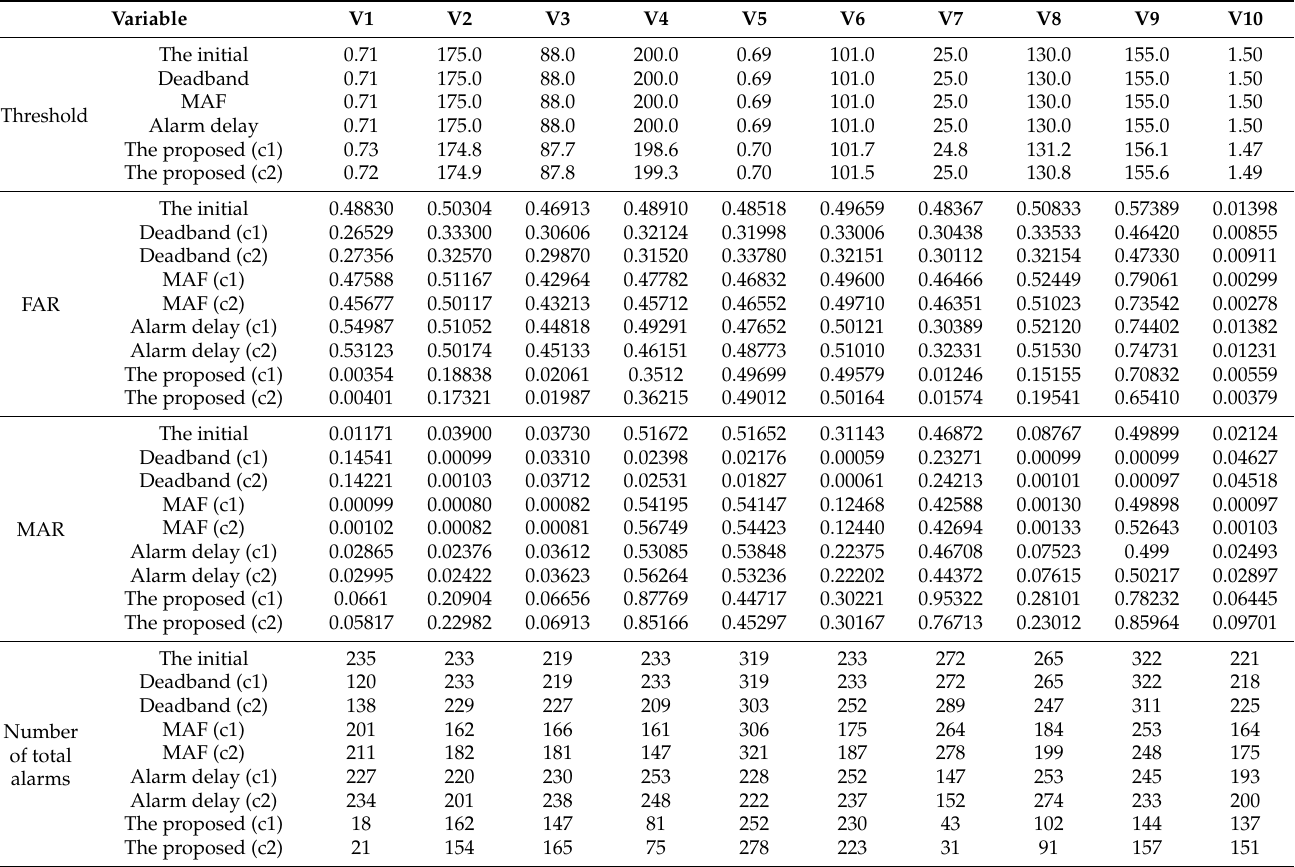
Table 11. Optimized results for 10